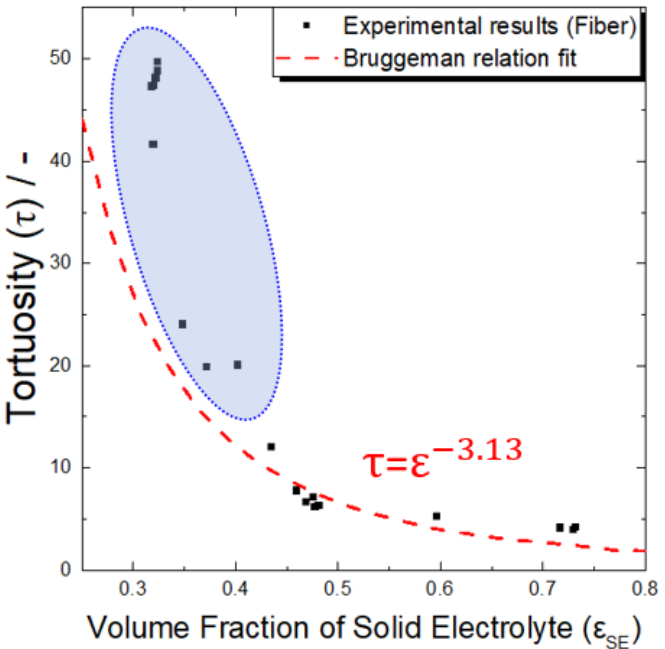
Figure 6. Tortuosities of the composite electrodes containing fibrous Al 2 O 3 as a function of volume fraction of solid electrolyte. The black symbols and red dotted line are the experimental results and fitted curve by Bruggeman equation, respectively. Blue dotted circle represents the experimental tortuosity values at low electrolyte volume fraction (or high Al 2 O 3 volume fraction), showing significant deviation from Bruggeman relation.